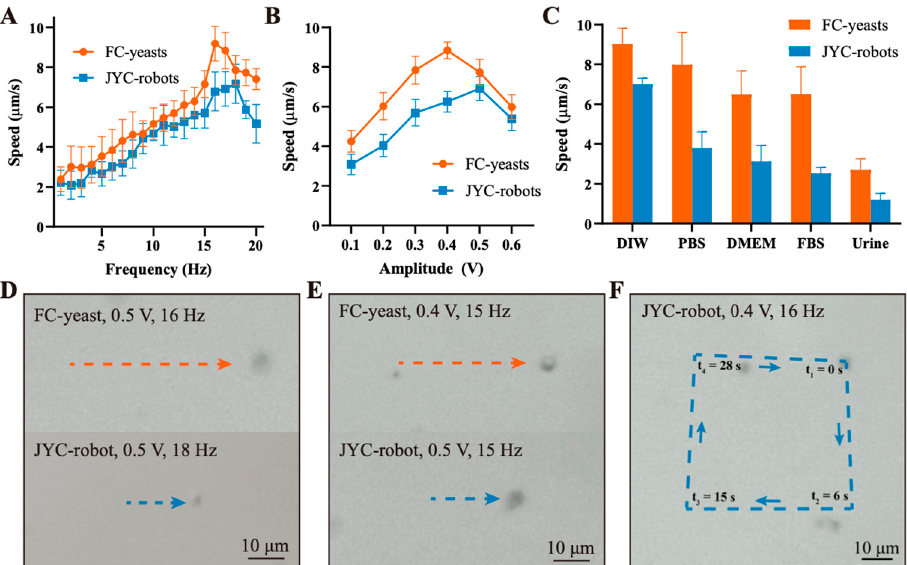
Figure 3. Propulsion performance of JYC-robots and FC-yeasts. Speed comparison of JYC-robots and FC-yeasts under ( A ) various frequencies (amplitude: 0.5 V) and ( B ) various amplitudes (frequency: 15 Hz). ( C ) Motion speed of JYC-robots and FC-yeasts in various media under magnetic field (0.4 V, 16 Hz). ( D ) Optical tracking trajectories over 5 s of JYC-robots and FC-yeasts at a constant amplitude of 0.5 V, taken from Movie S1. ( E ) Optical tracking trajectories over 5 s of JYC-robots and FC-yeasts at constant frequency of 15 Hz, taken from Movie S2. ( F ) Optical tracking trajectories of JYC-robots under magnetic control with a predefined path of square ( □ )-like shape (RMF: 0.4 V and 16 Hz, taken from Movie S5).